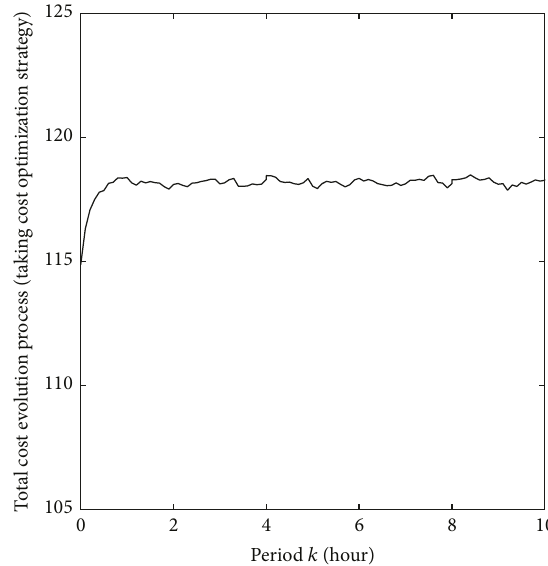
Figure 5: Evolution process of total cost with cost optimization strategy ( ×10 5 Yuan).